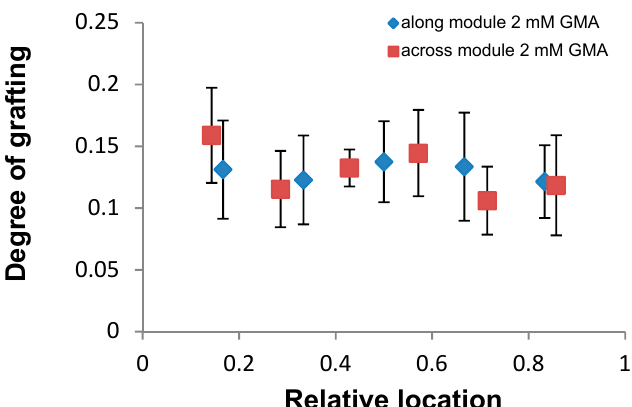
Figure 3. Degree of grafting (DG) of ESPA1-2521 elements modified with GMA at different locations along (entrance (0) to-exit (1)) and across (permeate edge (0) to-outer edge (1)) the element. The element was modified for 0.5 h using 2 mM GMA and 0.045 mM Triton solution. The error bars correspond to standard deviations of all DG measurements for a given location.